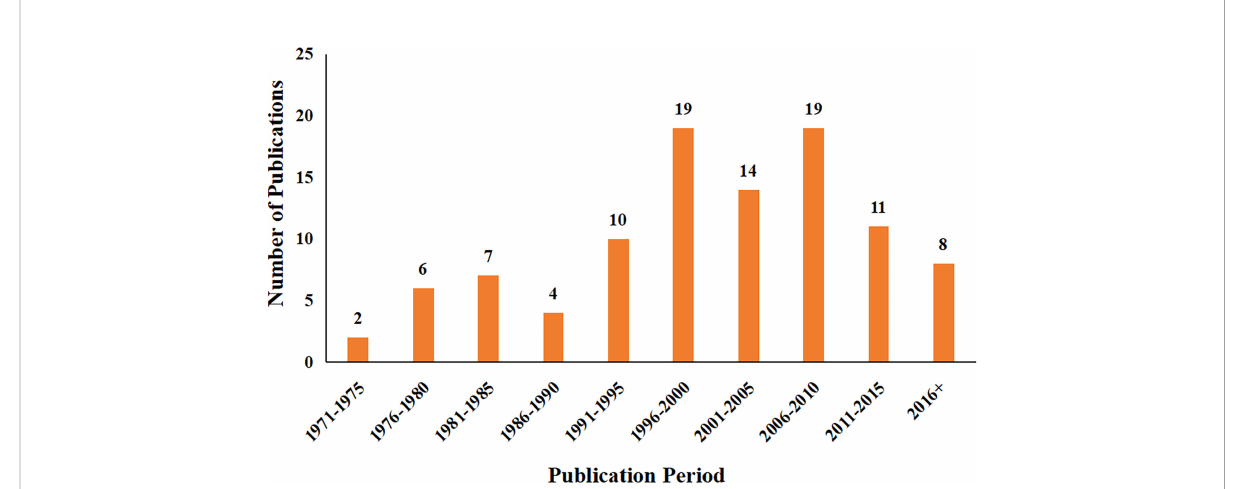
FIGURE 1 The number of papers published during each fi ve-year interval between 1971 and